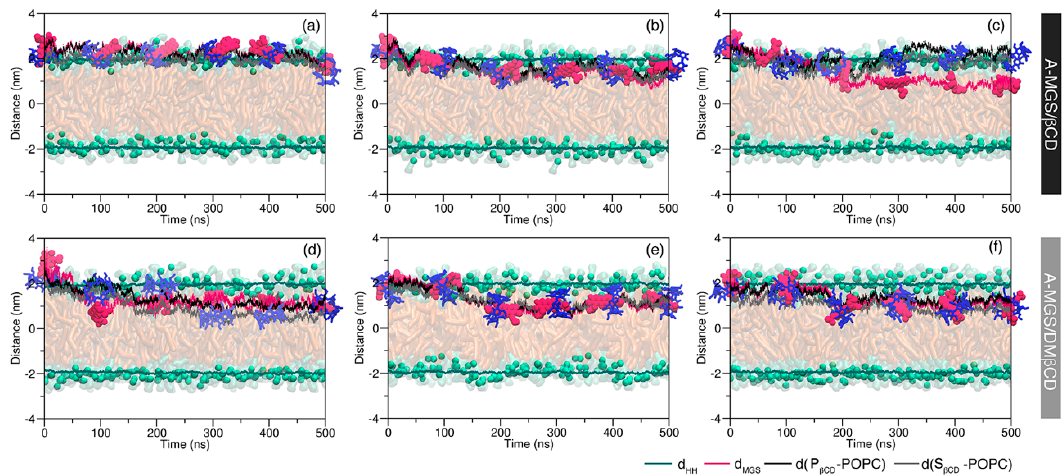
Figure 3. Time-dependent distance between the centers of mass of the lipid bilayer and the inclusion complexes of the A-form: ( a – c ) A-MGS / β CD and ( d – f ) A-MGS / DM β CD. The distance between the phosphate groups of each leaflet (d HH ) is represented by the green line, while the distances of MGS as well as the primary and secondary rims of CD, d(P CD ‐ POPC), and d(S CD ‐ POPC), relative to the lipid bilayer are represented by magenta, black, and grey lines, respectively. Representative snapshots of A ‐ MGS/ CDs during the simulation are also given in the presence of the membrane scheme for simplicity.